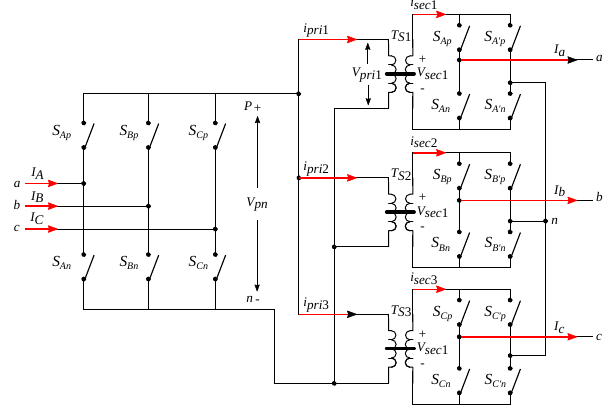
Figure 7. Complete model for the